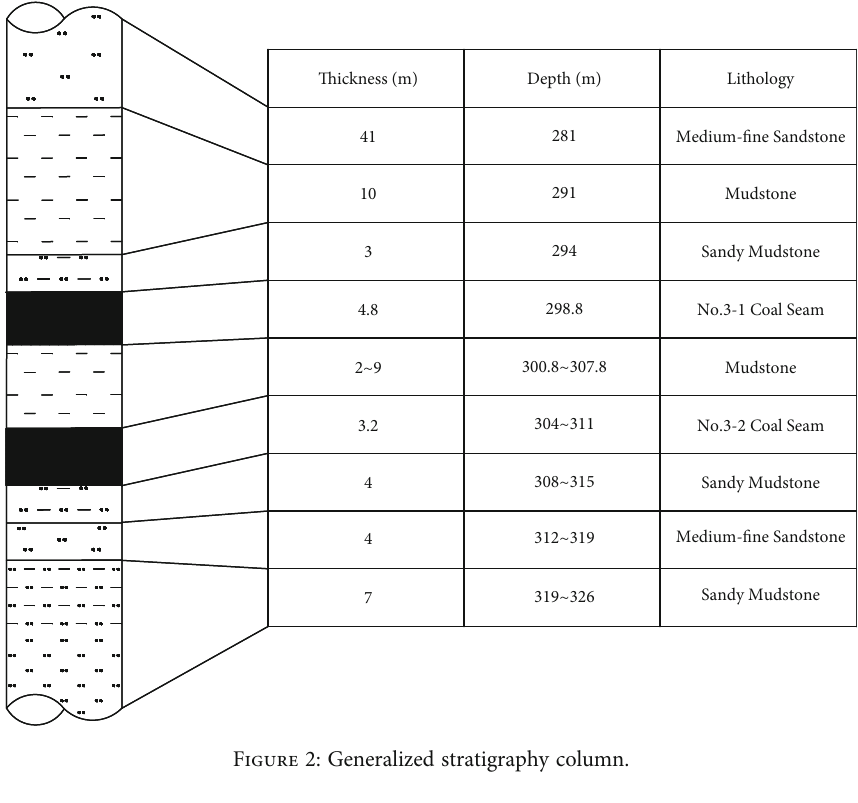
Figure 2: Generalized stratigraphy column.